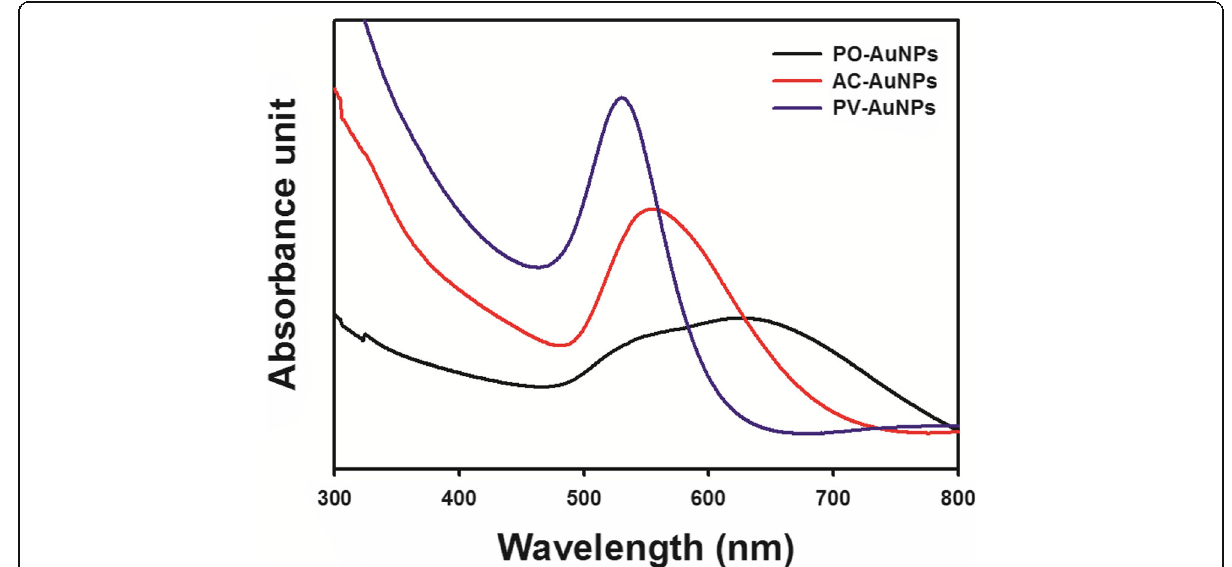
Fig. 3 UV-visible spectra of PO-AuNPs (black line), AC-AuNPs (red line), and PV-AuNPs (blue